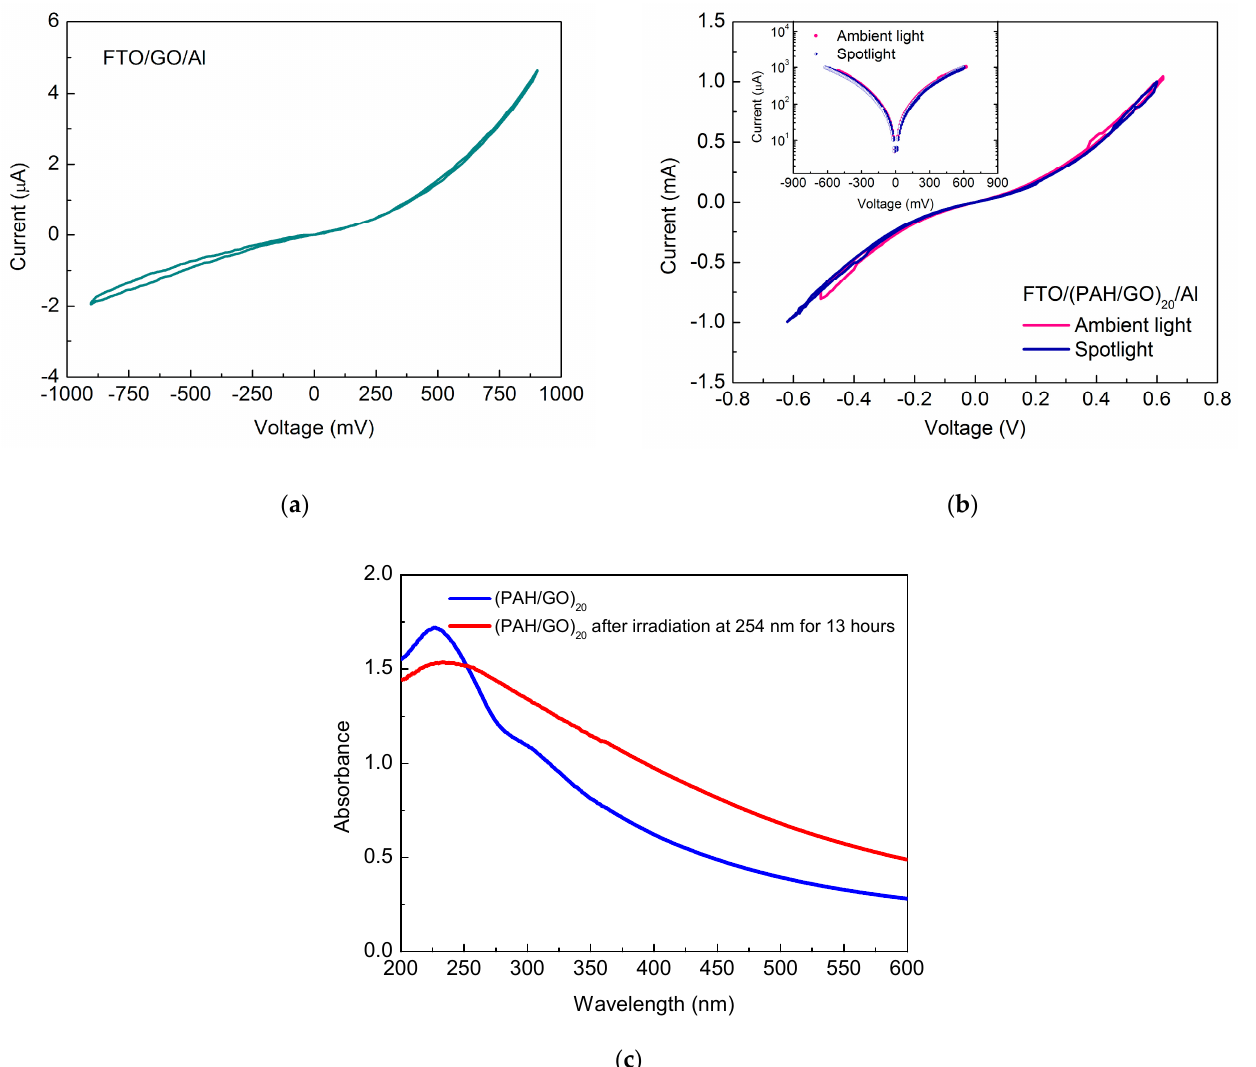
Figure 6. ( a ) Characteristics curves I (V) of the FTO/GO/Al device. ( b ) Characteristics curves I (V) of FTO/ (PAH/CO) 20 /AL, measured under ambient light and a halogen light source (spotlight), with the inset showing the same results presented as the larger figure ( b ), but now with change of scale and passage of negative to positive current. ( c ) UV-Vis spectra of (PAH/GO)20 LbL film before and after irradiation at 254 nm for 13 h.